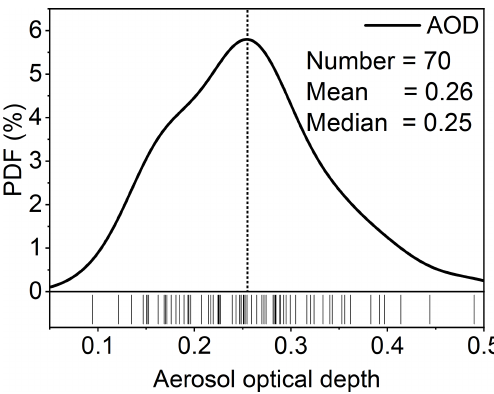
Figure 1. The locations of the TC centers for different TC intensi- ties, and the blue, green, and red dots represent the centers of TD, TS, and HU, respectively. The contour map is the spatial distribution of the average AOD from July to September during 2003–2019. The spatial ranges of the inner and the outer rectangles are (15–20 ◦ N, 45–25 ◦ W) and (10–25 ◦ N, 50–20 ◦ W), respectively. It should be noted that the AOD is generally averaged in the absence of clouds, i.e., no TC activities.